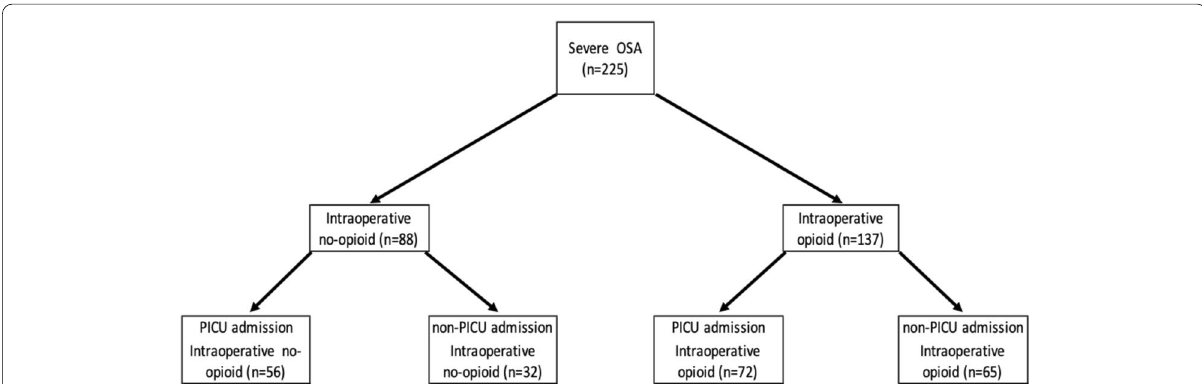
Fig. 1 Consort diagram. Two hundred twenty‑five children with severe OSA (AHI without opioid and 137 children underwent anesthesia with opioid. Among the anesthesia without opioid group, 56 children were admitted to PICU and 32 children were non‑PICU admission. Among the anesthesia with opioid group, 72 children were admitted to PICU and 65 children were non‑PICU